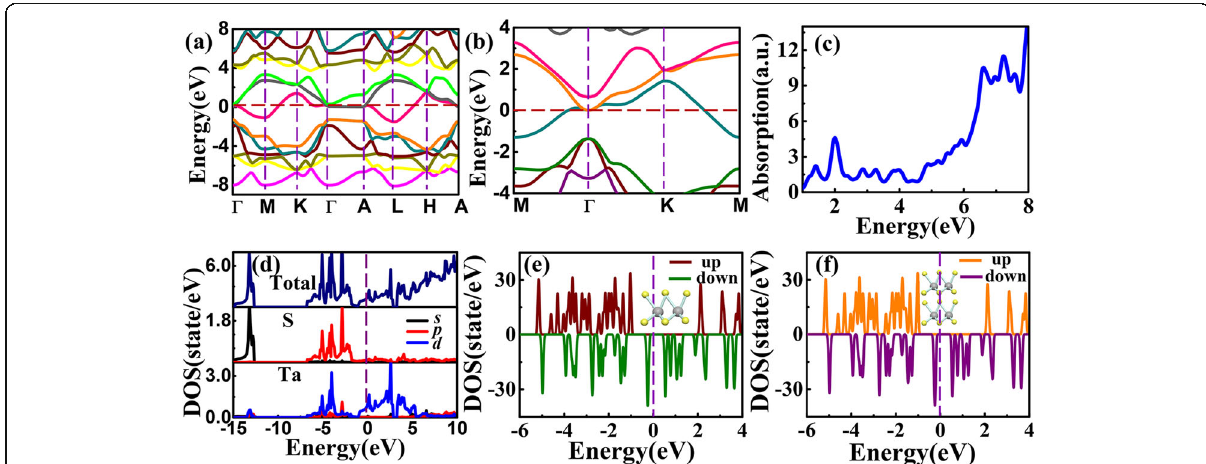
Fig. 6 a Bulk and b monolayer TaS 2 by HSE functionals. c Optical absorption spectra of monolayer TaS 2 . d PDOS by calculated by HSE. e The monolayer and f the two-layer DOS of QDs calculated by HSE